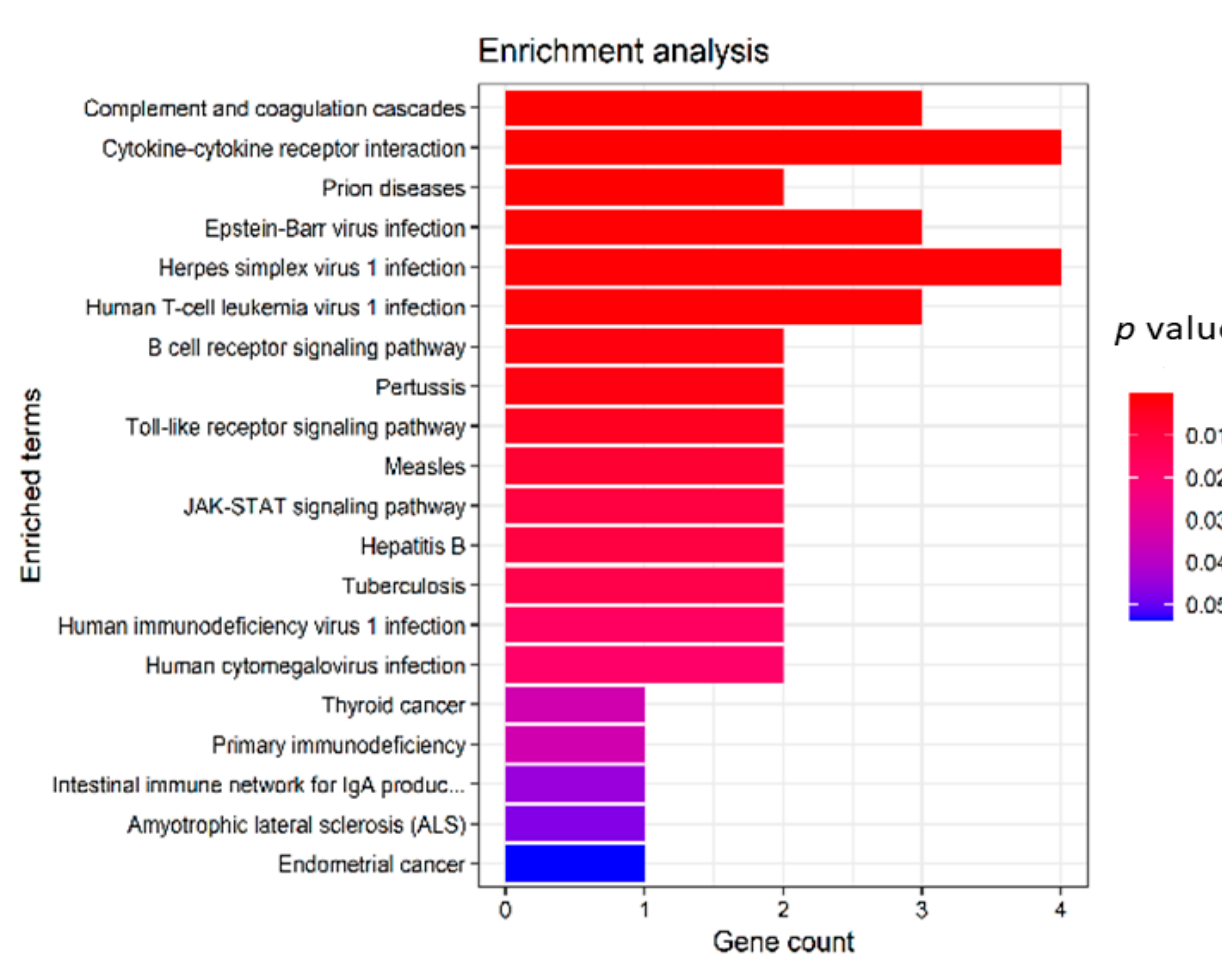
Figure 6. A boxplot denoting the downregulation of the C9 gene in the steatosis samples.